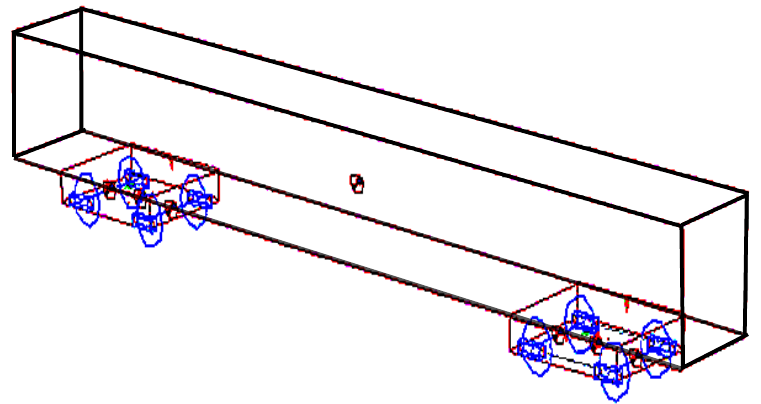
Figure 4. Railway vehicle model.